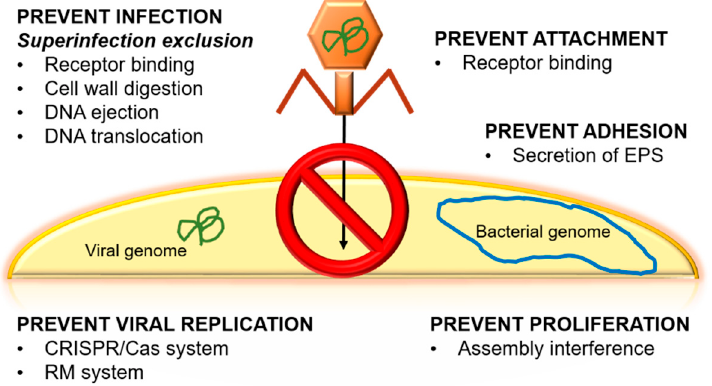
Figure 2. Principal natural mechanisms to prevent viral infection in bacteria. EPS: extracellular polymeric substances, CRISPR/Cas: Clustered Regularly Interspaced Short Palindromic Repeats/Caspase, RM: restriction modification.